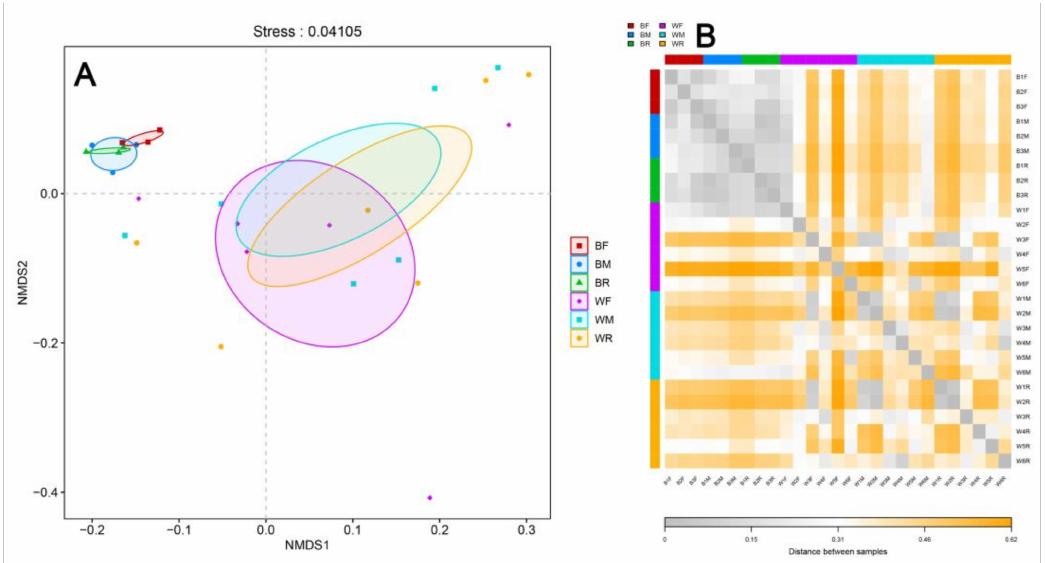
Figure 4. Heatmap analysis ( B ) and non-metric multidimensional scaling (NMDS) analysis ( A ) of the gut microbiota in cultivated and wild Mastacembelus armatus